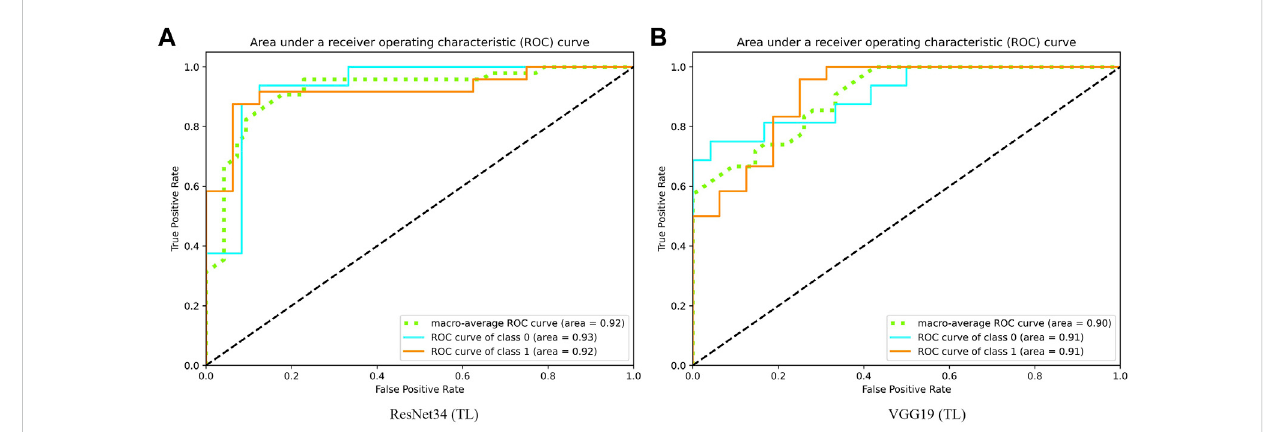
FIGURE 3 Graph of area under receiver operating characteristic curve of (A) ResNet34 and (B)